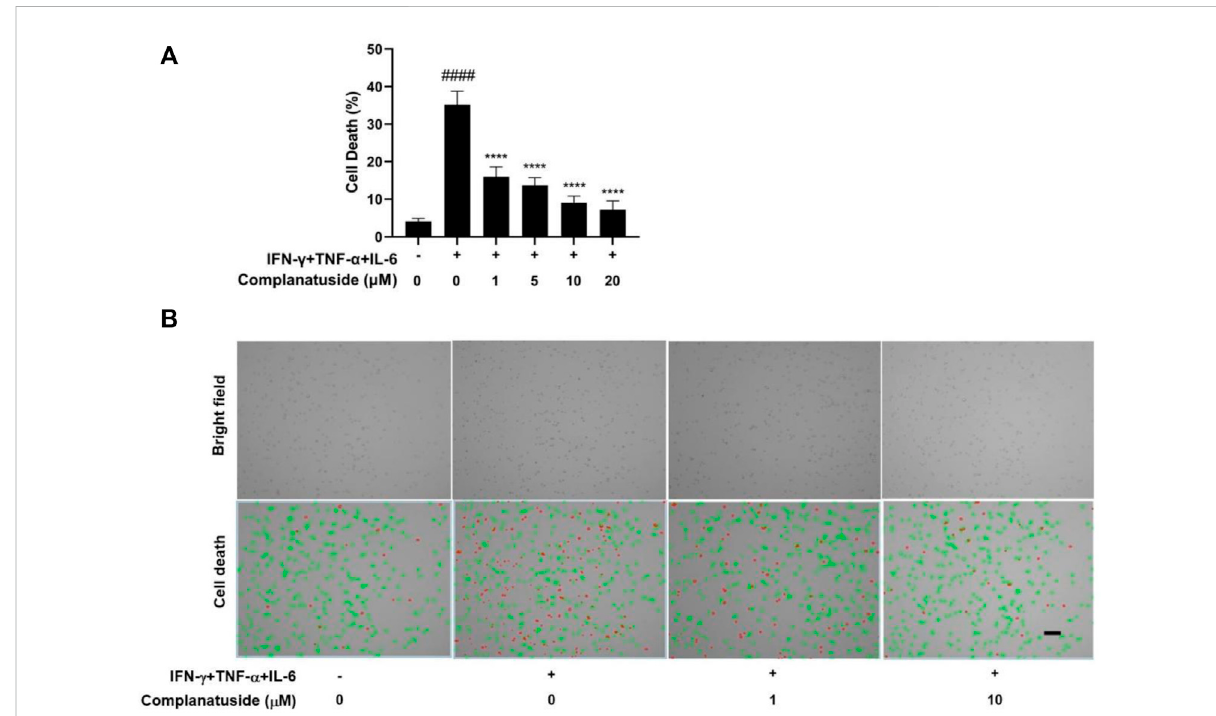
FIGURE 4 Protective effect of complanatuside on HaCaT cell death induced by the cytokine combination. HaCaT cells were treated with various concentrations ofcomplanatuside in theabsence or presence of cytokine combinationand cell death was determined by theTrypan blueexclusion assay. (A) Percentage of cell death in HaCaT cells treated with the cytokine combination in the presence or absence of complanatuside. The data werepresentedasmean±SD( n =3), #### = p < 0.0001ascomparedwiththecontrolgroup, **** = p < 0.0001ascomparedwiththecytokine combination-treated group. (B) Images of control cells, cytokine combination-treated cells, cells treated with cytokine combination, and complanatuside (1 or 10 μ M) were taken by the Countess ® automatic cell counter. Red color represents dead cells and green represents living cells (Size bar = 50